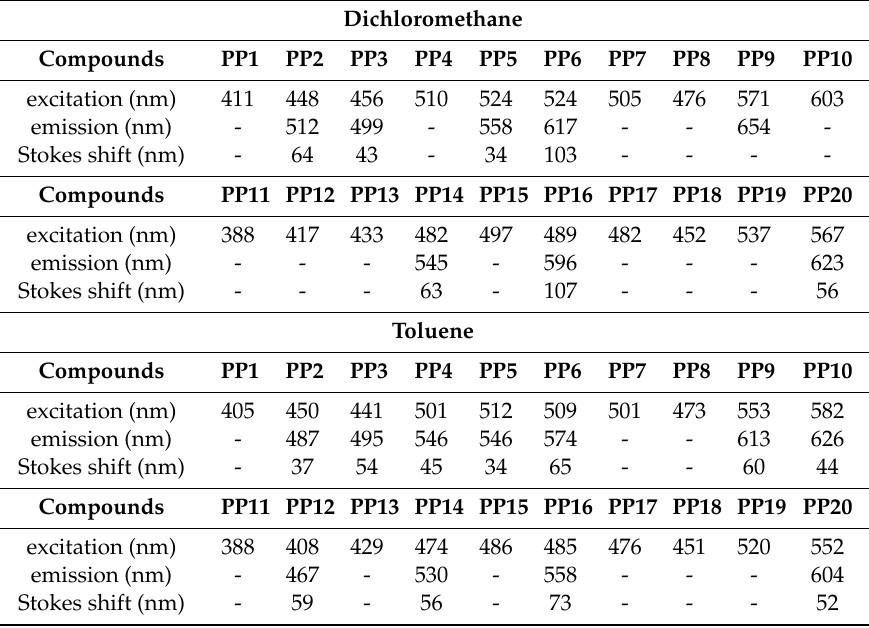
Table 5. Fluorescence properties of the di ff erent compounds in dichloromethane and toluene solutions.